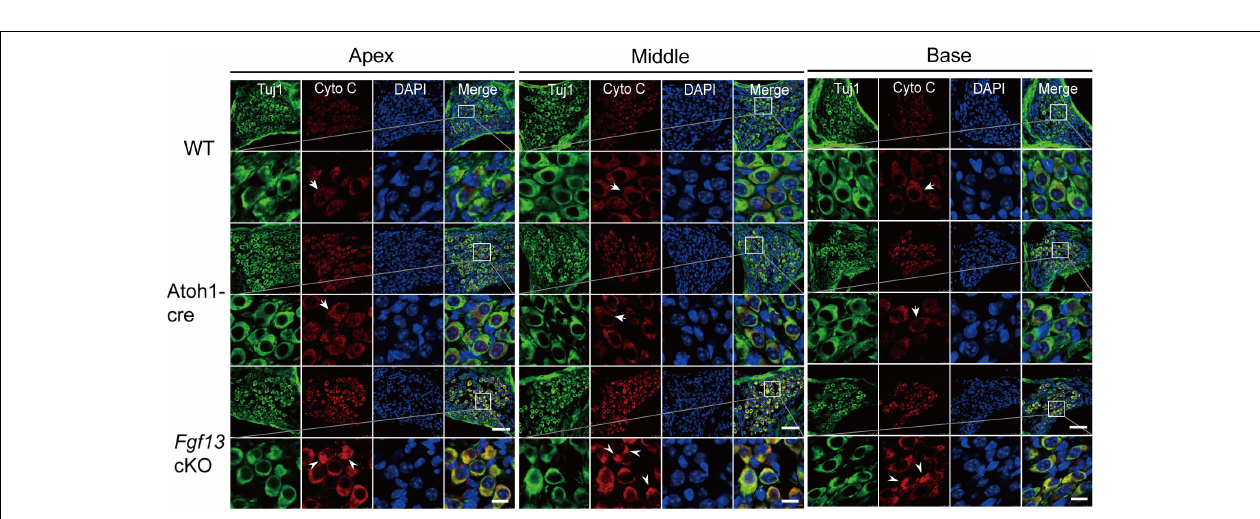
FIGURE 10 | Fgf13 cKO alters cytochrome C localization in SGNs. Immunofluorescence shows uniformly distributed cytochrome C (red) as puncta (arrows) from the apex to the base in SGNs of WT and Atoh1-cre mice. However, the distribution of cytochrome C was no longer uniform in the cytoplasm and are aggregated as a plaque (arrowhead) with increased expression in the cytoplasm of SGN in Fgf13 cKO mice. Scale bar = 50 µ m (top) and 10 µ m (bottom).